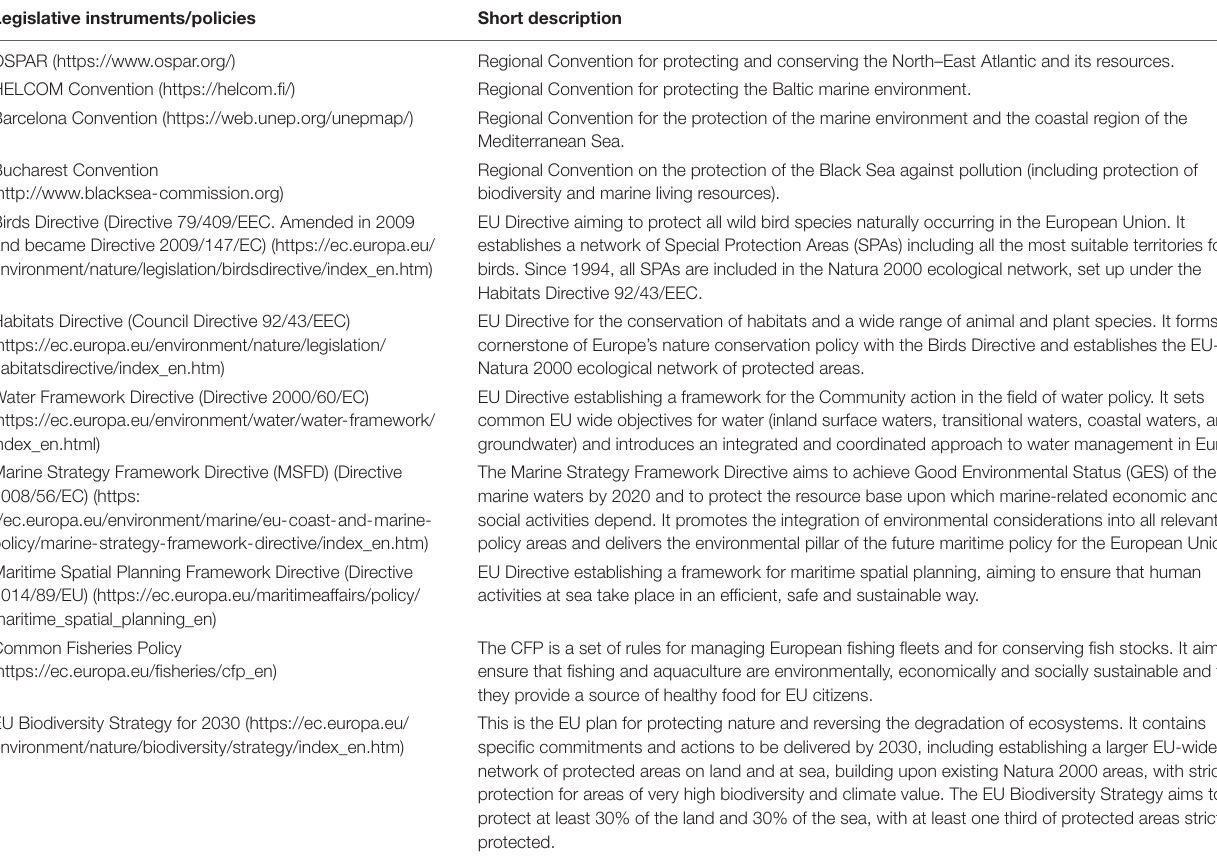
TABLE 1 | Conventions and legislative instruments contributing to conservation efforts in Europe and contiguous